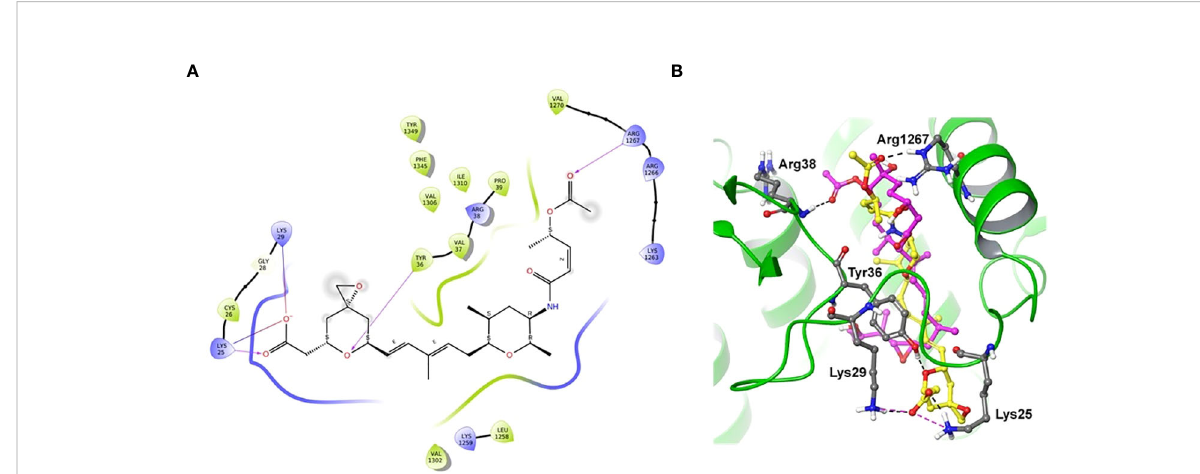
FIGURE 7 Two-dimensional interaction diagram and overlaid representation of spliceostatin C and pladienolide B with a homology model of SF3B1- PHF5A. Overlay of SPC (carbon in yellow) and pladienolide B (magenta) with homology model of SF3B1-PHF5A subunits of A . thaliana (A) ; The docking results showed that spliceostatin C formed H-bonding with Arg1267 and Tyr36, which are critical residues for herbicidal activity. In addition, it forms salt-bridges with Lys 25 and 29. Overall, the spliceostatin C occupied the same site where pladienolide B binds in SF3B1- PHF5A subunits (B)